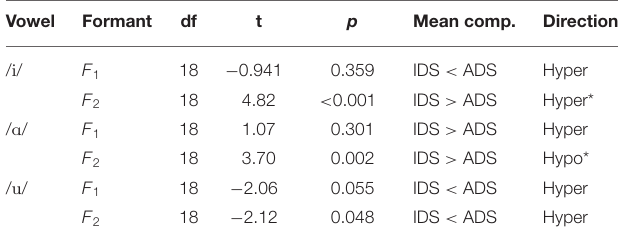
TABLE5 | Paired-samples t -test comparing formant values in IDS and ADS for / i /, / A /, and / u /. Vowel Formant